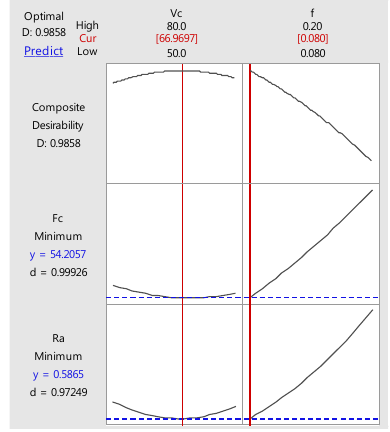
Fig. 8. Response Optimization for Surface Roughness and Cutting Force